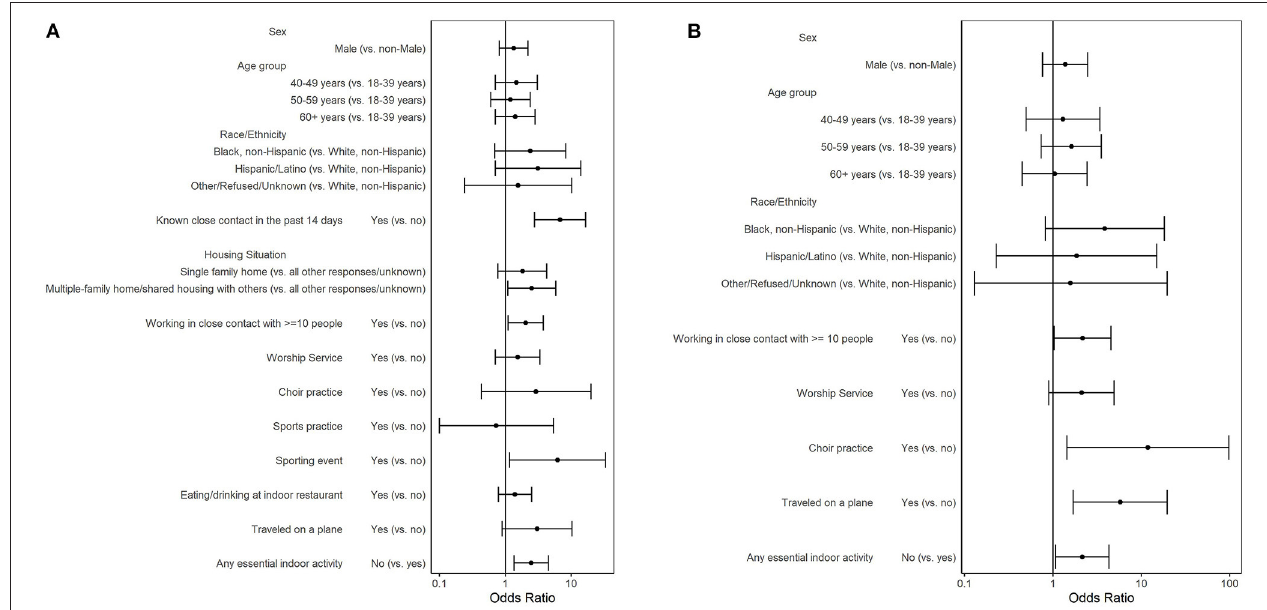
FIGURE 1 | Adjusted odds ratios of a positive SARS-CoV-2 RT-PCR result: by COVID-19 exposure and by risk factors for COVID-19 exposure among (A) participants who did not report a prior positive COVID-19 test ( n = 1,026) and (B) participants who did not report a prior positive SARS-CoV-2 test and had no known close contact to a COVID-19 case ( n = 864); a study at a large urban, public hospital in Fulton County, GA, August-November